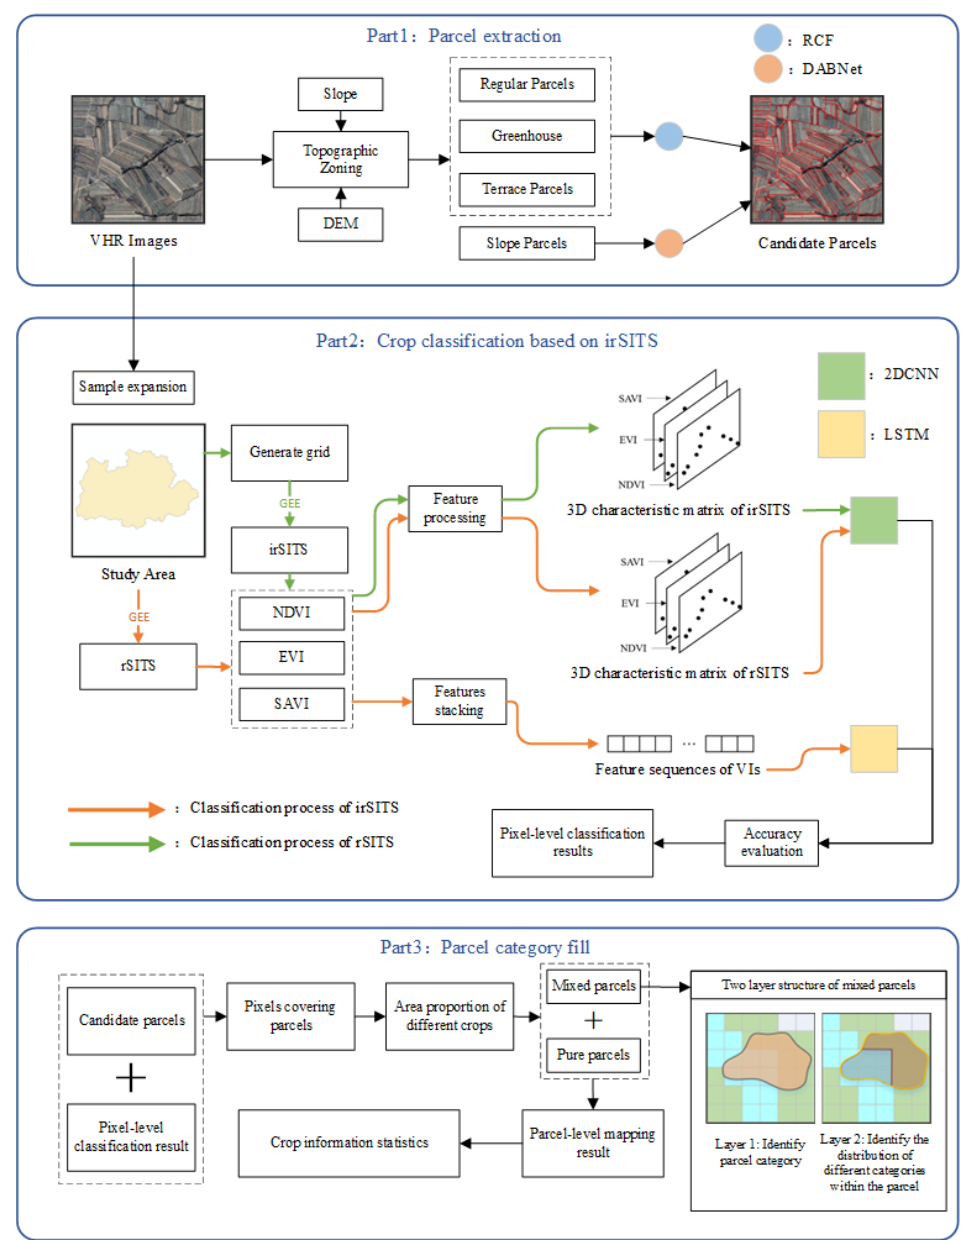
Figure 5. Workflow of the method proposed in this paper.